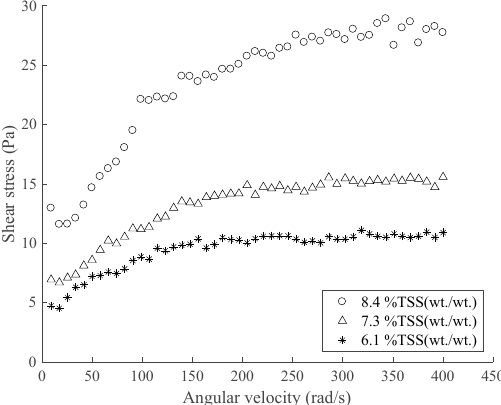
Figure 4. Shear-stress vs. angular velocity measurements for CDS using the wide gap geometry.